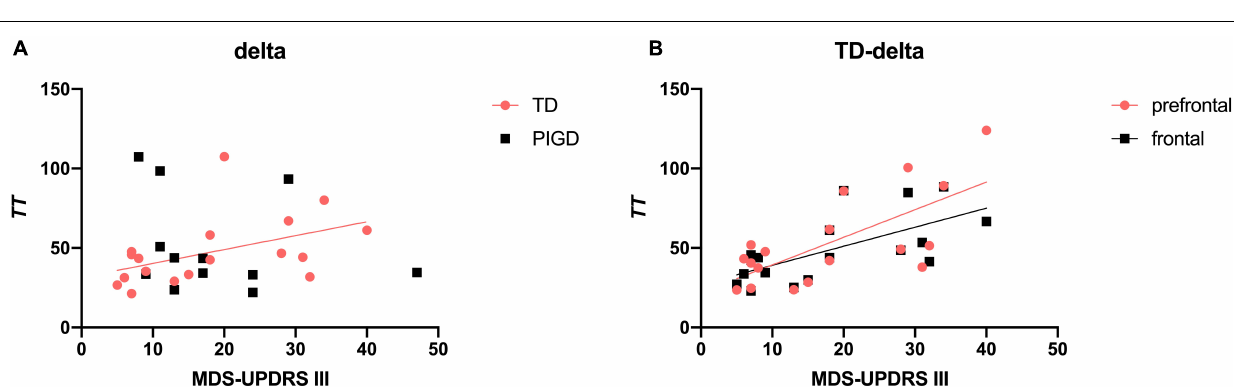
were positively correlated with increases in HAMD, especially in the prefrontal region ( k PLI delta: r = 0.540, p < 0.05, Figure 4E ; k PLI theta: r = 0.476, p < 0.05, Figure 4F ). Similarly, a relationship was found between k PLI theta and HAMA in the prefrontal region ( r = 0.620, p < 0.01, Figures 4C,G ). quality (RBDSQ and PDSS-2). K PLI gamma was